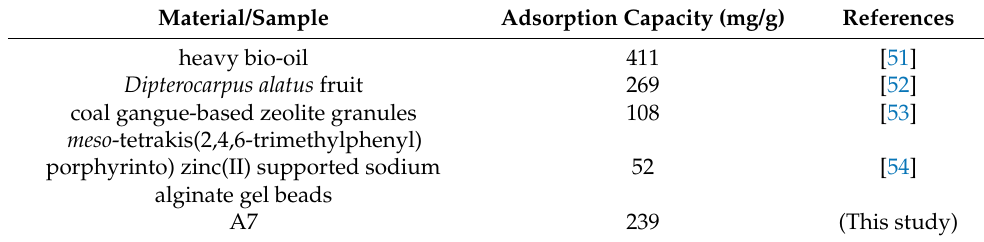
Table 9. Methylene blue sorption capacity of selected